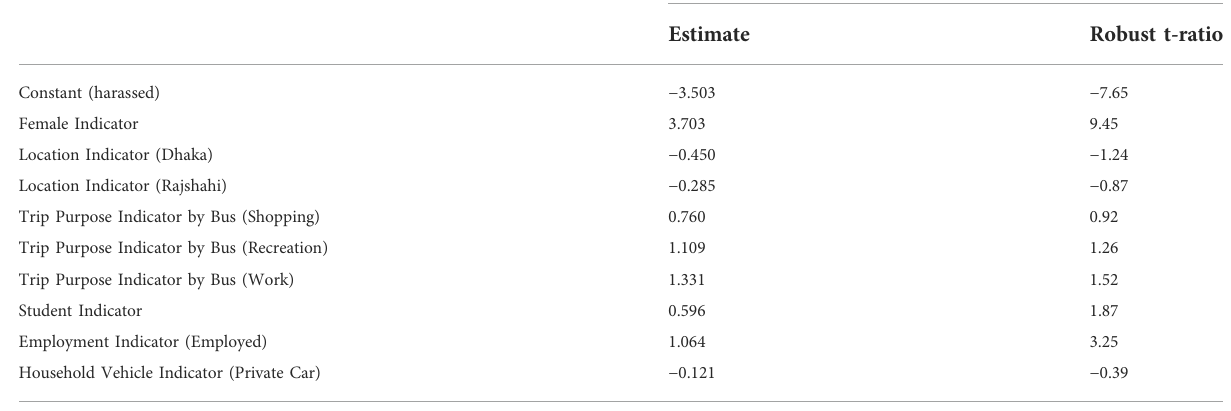
TABLE 2 Binary logit models results: who are more likely to get